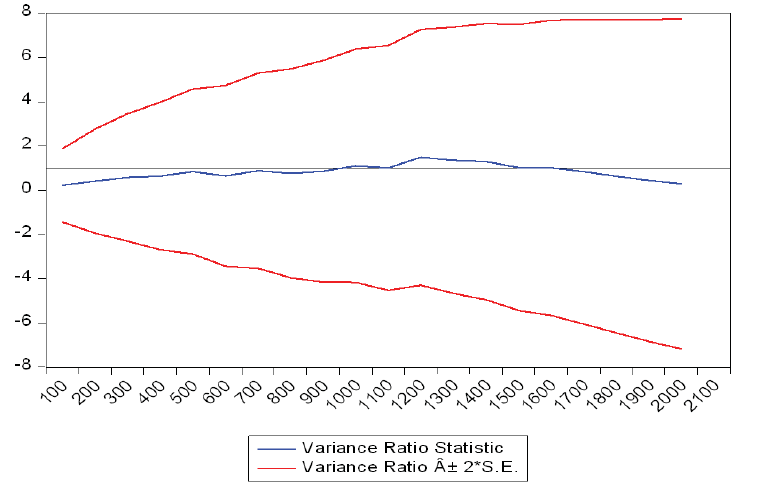
Fig. 1. Graphical illustration of the efficiency of the DSE ALSI daily data over the test periods (November 2006 to August 2015)